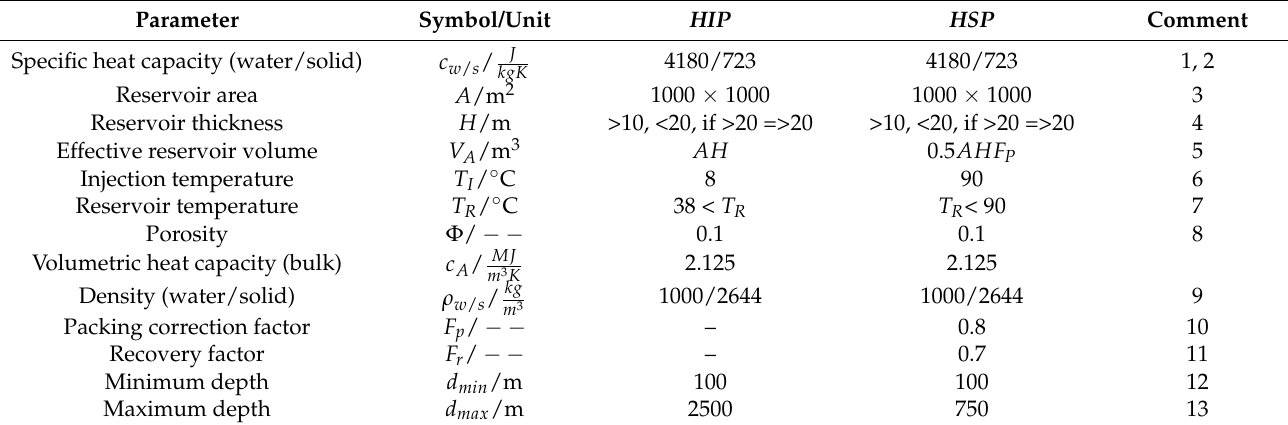
Table 1. Input parameters for the different calculations. HIP = heat in place, HSP = storage